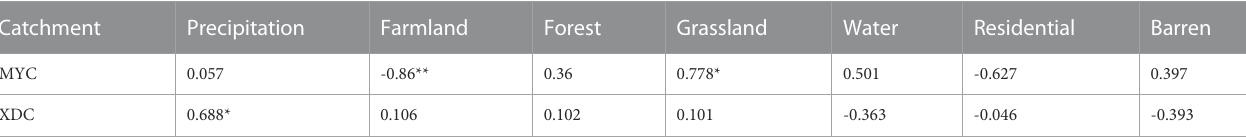
TABLE 1 Correlation coef fi cients between stream fl ow and precipitation, land use in MYC and XDC. Catchment Precipitation